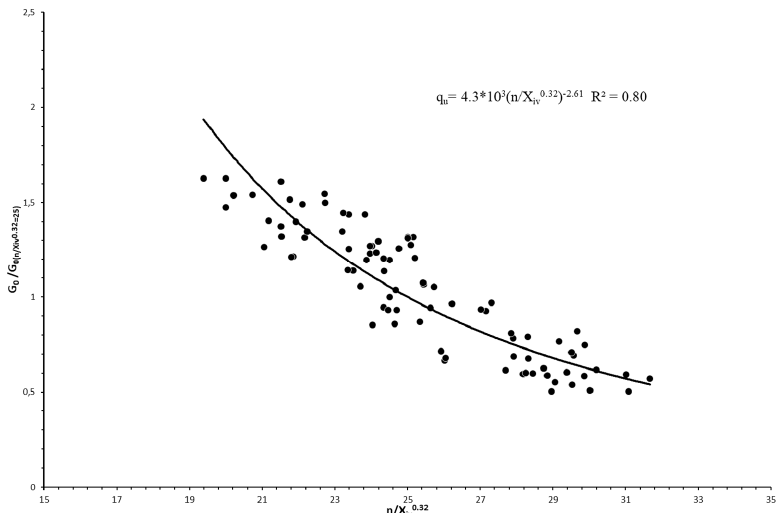
Figure 10. Normalization of initial shear modulus (G 0 ) (for the whole range of η /X iv0.32 ) by dividing G 0 at η /X iv0.32 = 25, considering all studied blends.